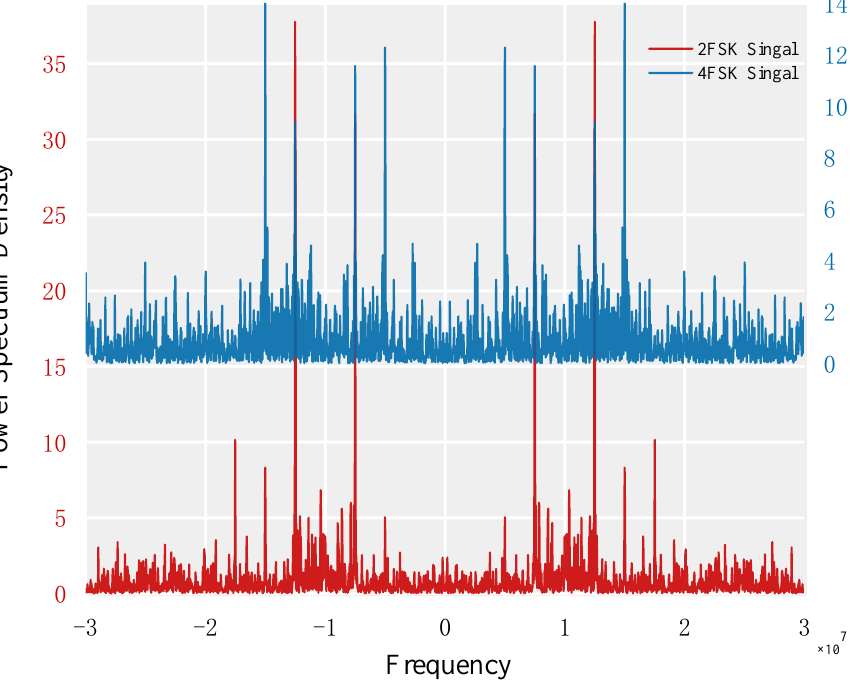
Figure 4. Power spectral density of 2FSK and 4FSK.